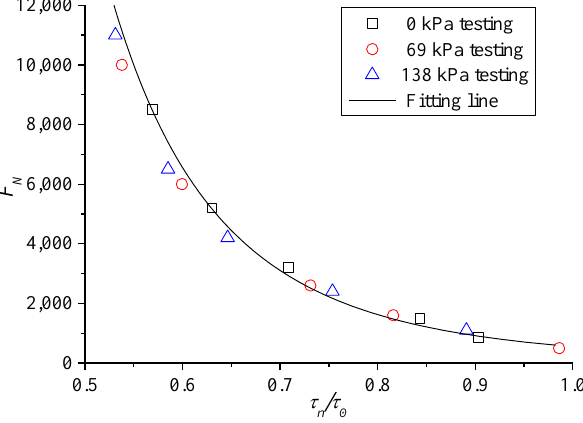
Figure 13. Curve chart of F N with shear stress ratio.